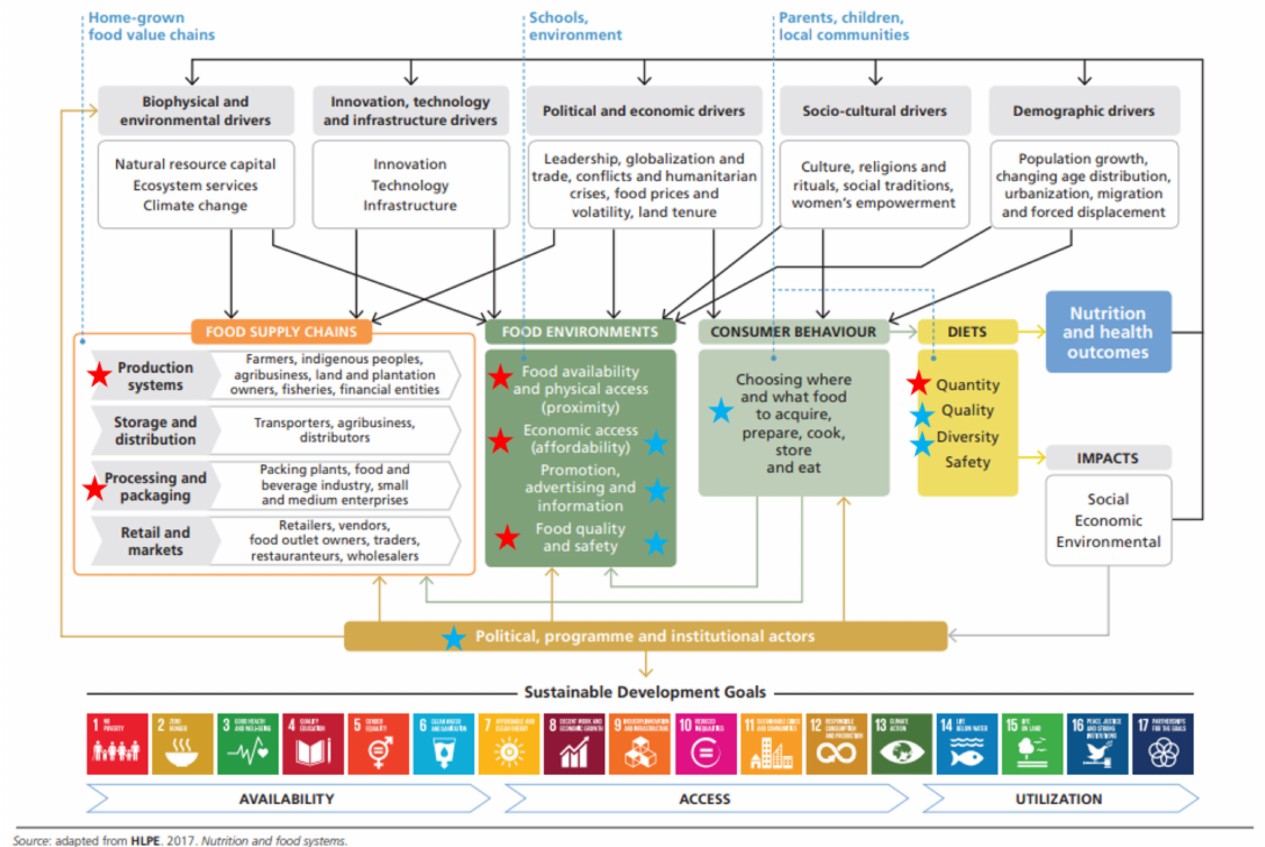
Figure 2. Food systems framework with entry points for HGSF [47] (Reproduced with permission from FAO and WFP, Rome, Italy), with identified challenges marked with red stars and good practices with blue stars. Note: Economic access and food quality and safety were highlighted as challenges in some records, while good practices were also identified in relation to